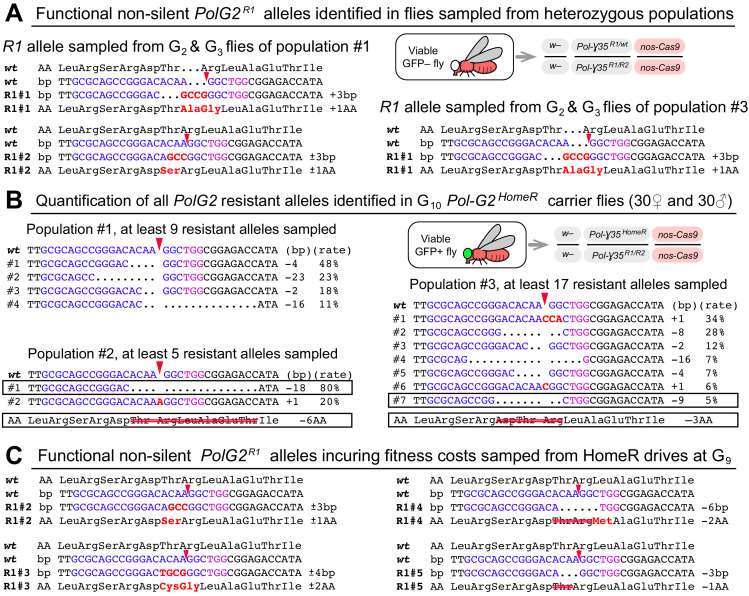
PolG2 resistant alleles induced by PolG2HomeR in experimental populations.(A) Two functional non-silent resistant (R1) alleles were sampled in nine GFP-negative viable flies segregating from the heterozygous PolG2HomeR/PolG2WT; nos-Cas9/nos-Cas9 fly populations at generations 2 and 3. None of the nine GFP-negative flies harbored the PolG2WT allele. Instead, each fly carried at least one functional non-silent resistant allele rescuing the viability of these flies. Both PolG2R1 types changed the amino acid sequence, hence they are referred to as non-silent R1 alleles. Seven out of nine flies were heterozygous, harboring one of the identified PolG2R1 alleles together with an out-of-frame indel (loss-of-function [LOF]) allele. The remaining two GFP-negative flies were likely homozygous for the R1#1 allele, because 10 randomly sequenced clones harbored the same allele. (B) Resistant alleles, persisting for 10 generations of cleavage and homing (Figure 2A), were sampled from 60 flies chosen randomly harboring at least one PolG2HomeR allele and quantified using Illumina sequencing. For each population, nearly 50,000 amplicons of PolG2 alleles (150K total), which did not carry the 2.5 kb insert of the HomeR, were sequenced and used to estimate the minimum number of sampled resistant alleles. Note that both PolG2R1 alleles (R1#1 and R1#2) identified at earlier generations (A) were not sampled after generation 10. Two in-frame resistant alleles (−18 and −9 bp, boxed) resulted in deletions of six or three amino acids and would likely incur fitness costs without the HomeR’s rescue to their carriers. (C) Four functional non-silent PolG2R1 alleles were found to incur fitness costs on female carriers. These alleles were identified in seven GFP– females sampled at generation 9 from drives 4 and 5 (Figure 2B); when crossed to wt males, these females died in 3 days leaving no progeny and were genotyped. Every genotyped female was heterozygous for one of the four in-frame non-silent functional R1 alleles and an out-off-frame indel LOF allele. Interestingly, the sampled GFP– males were fertile, and four genotyped males harbored the same R1#3 allele. Note that one ‘short-lived’ female had the functional non-silent R1#2 allele previously identified in heterozygous population #1 (A). For all presented resistant alleles, the sequence of gRNA#1PolG2 is highlighted in blue, and its PAM sequence is in purple. Red arrows depict Cas9/guideRNA (Cas9/gRNA) cut sites. Base insertions and amino acid changes are in red. Deleted amino acids are crossed by double red lines.